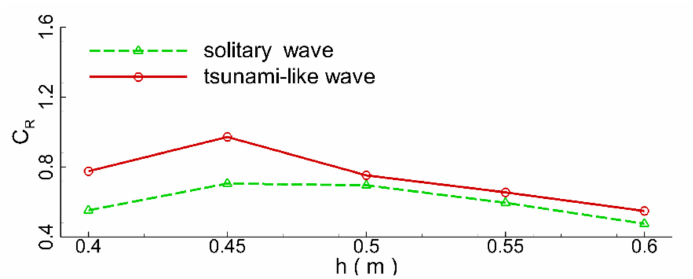
Figure 23. Variations in the wave reflection coefficient with the still water